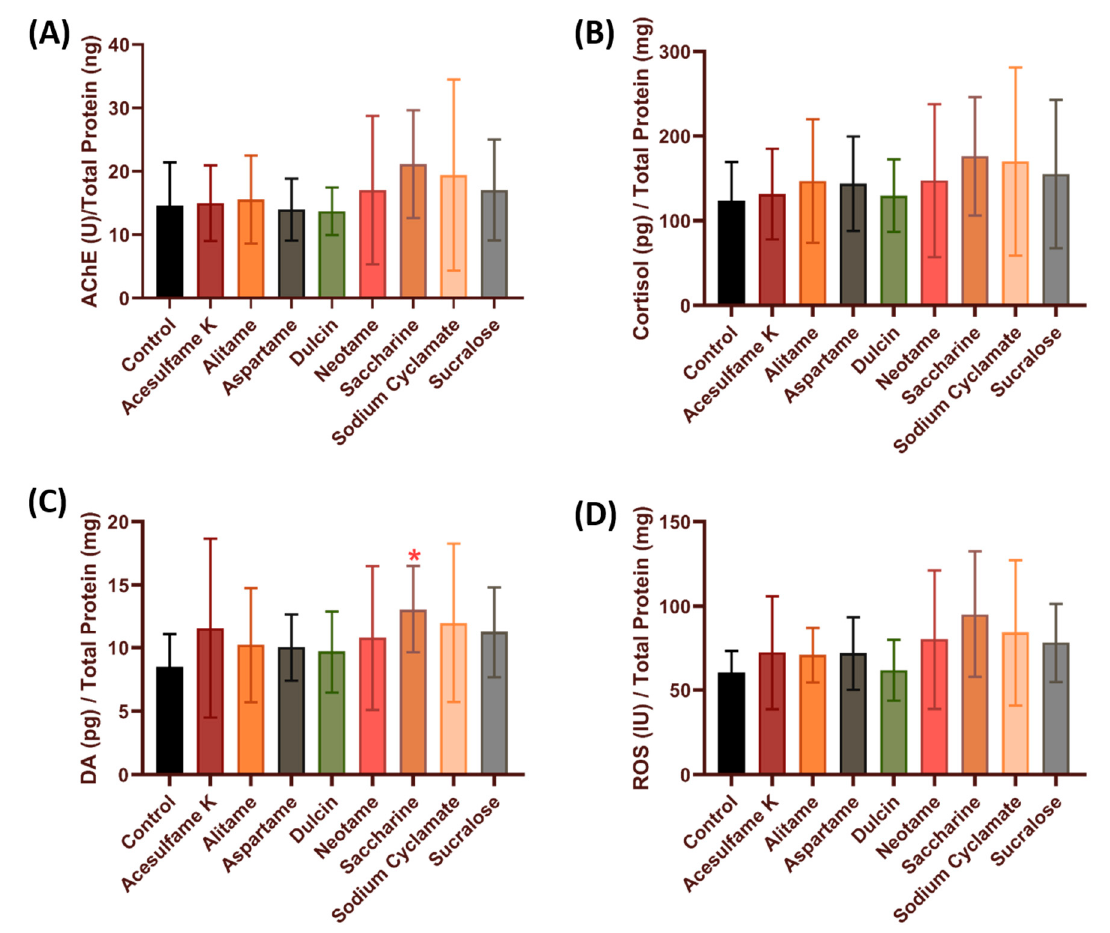
Figure 5. Comparison of neurotransmitter related to stress and oxidative stress in zebrafish embryos after incubation of eight different artificial sweeteners at highest environmental relevant concentration (100 ppb). ( A ) AChE (acetylcholinesterase), ( B ) cortisol, ( C ) dopamine and ( D ) ROS (reactive oxygen species). Data were presented as mean ± SEM and statistical significances were tested by Brown-Forsythe ANOVA test followed by post-hoc unpaired t with Welch’s correction test as multiple comparison test ( n = 5). Red asterisk shows significant increase (* p < 0.05).